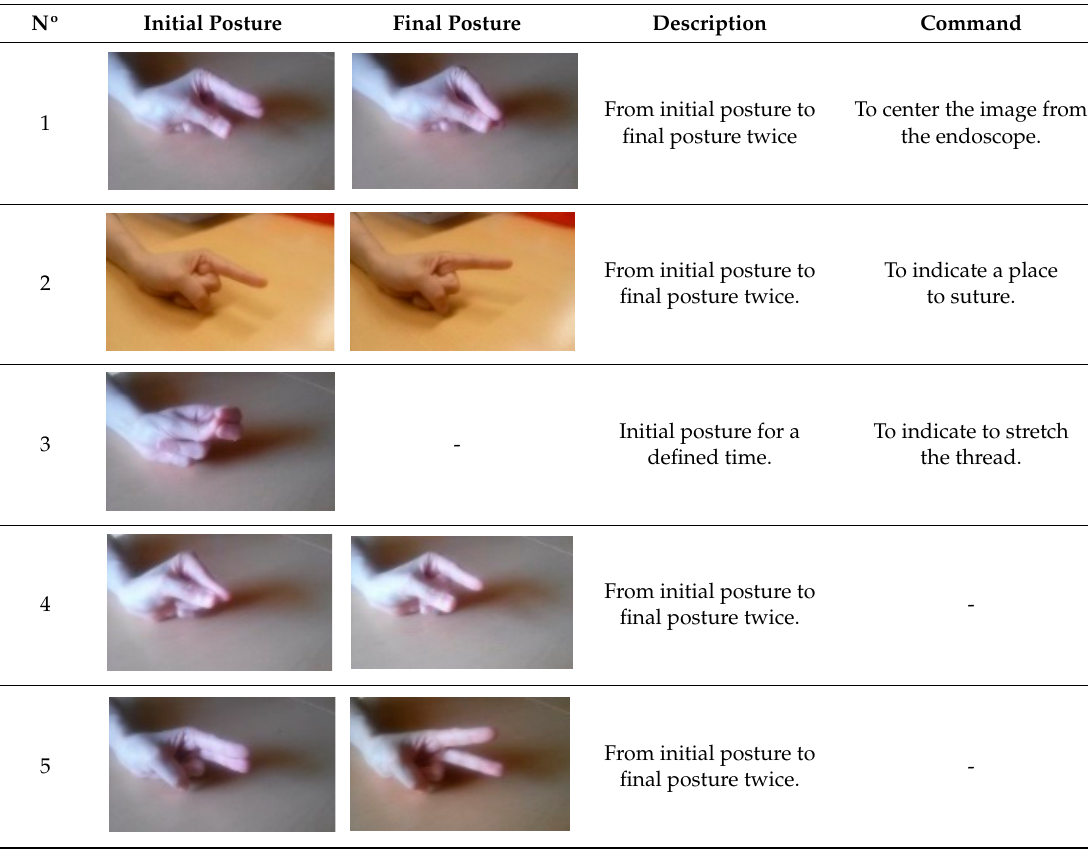
Table 1. Selected movements to be Table 1. Selected movements to be detected. Table 1. Selected movements to be detected. 148 Table 1. Selected movements to be detected. Table 1. Selected movements to be detected. Table 1. Selected movements to be detected. Table 1. Selected movements to be detected. Table 1. Selected movements to be detected. Table 1. Selected movements to be detected. Table 1. Selected movements to be detected.